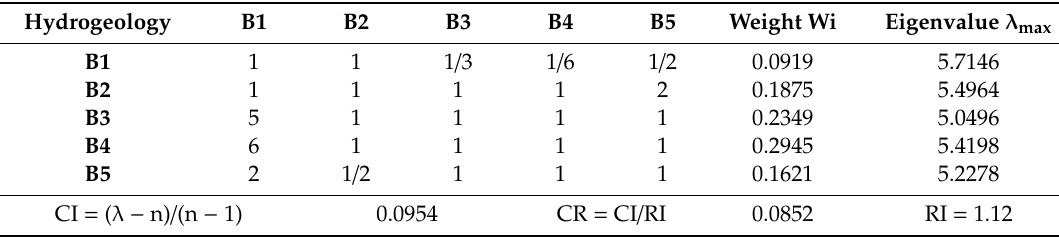
Table 6. A single sequence of the hydrogeology and consistency